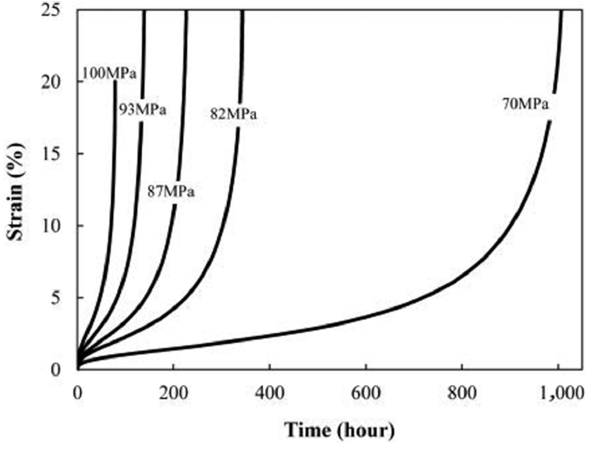
Figure 14: Creep strain versus time curves obtained from uniaxial tests for grade P91 steel at 650°C.